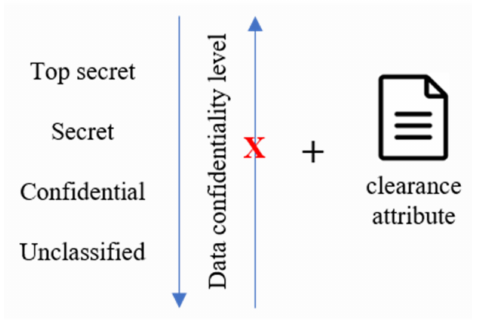
Figure 3. Implementation of the MAC model.